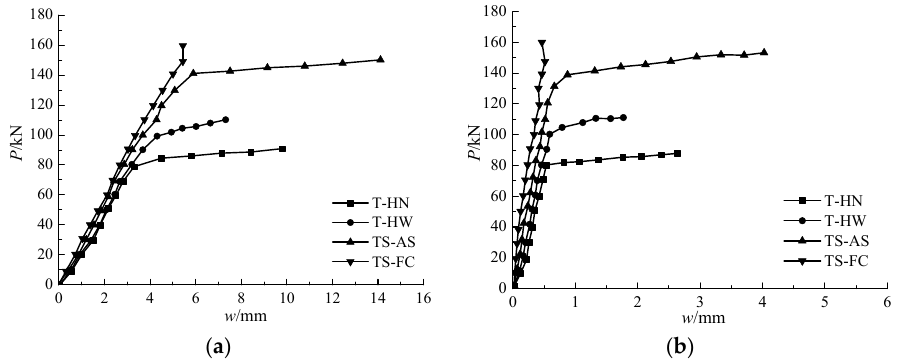
Figure 8. Total vertical loading–deflection curves of specimens. ( a ) Midspan (transducer D1); ( b ) End joint ‘p’ (transducer D3).